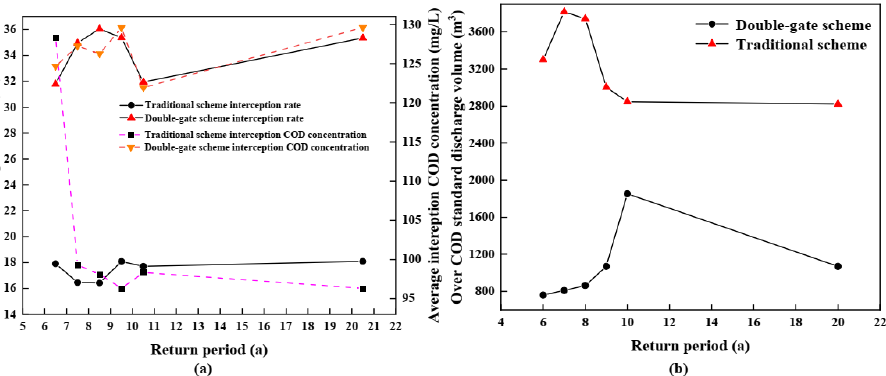
Figure 13. The simulation of double-gate scheme based on water quality and traditional scheme under different return periods: ( a ) COD interception rate and average COD concentration interception rate; ( b ) Overflow volume of COD concentration over 50